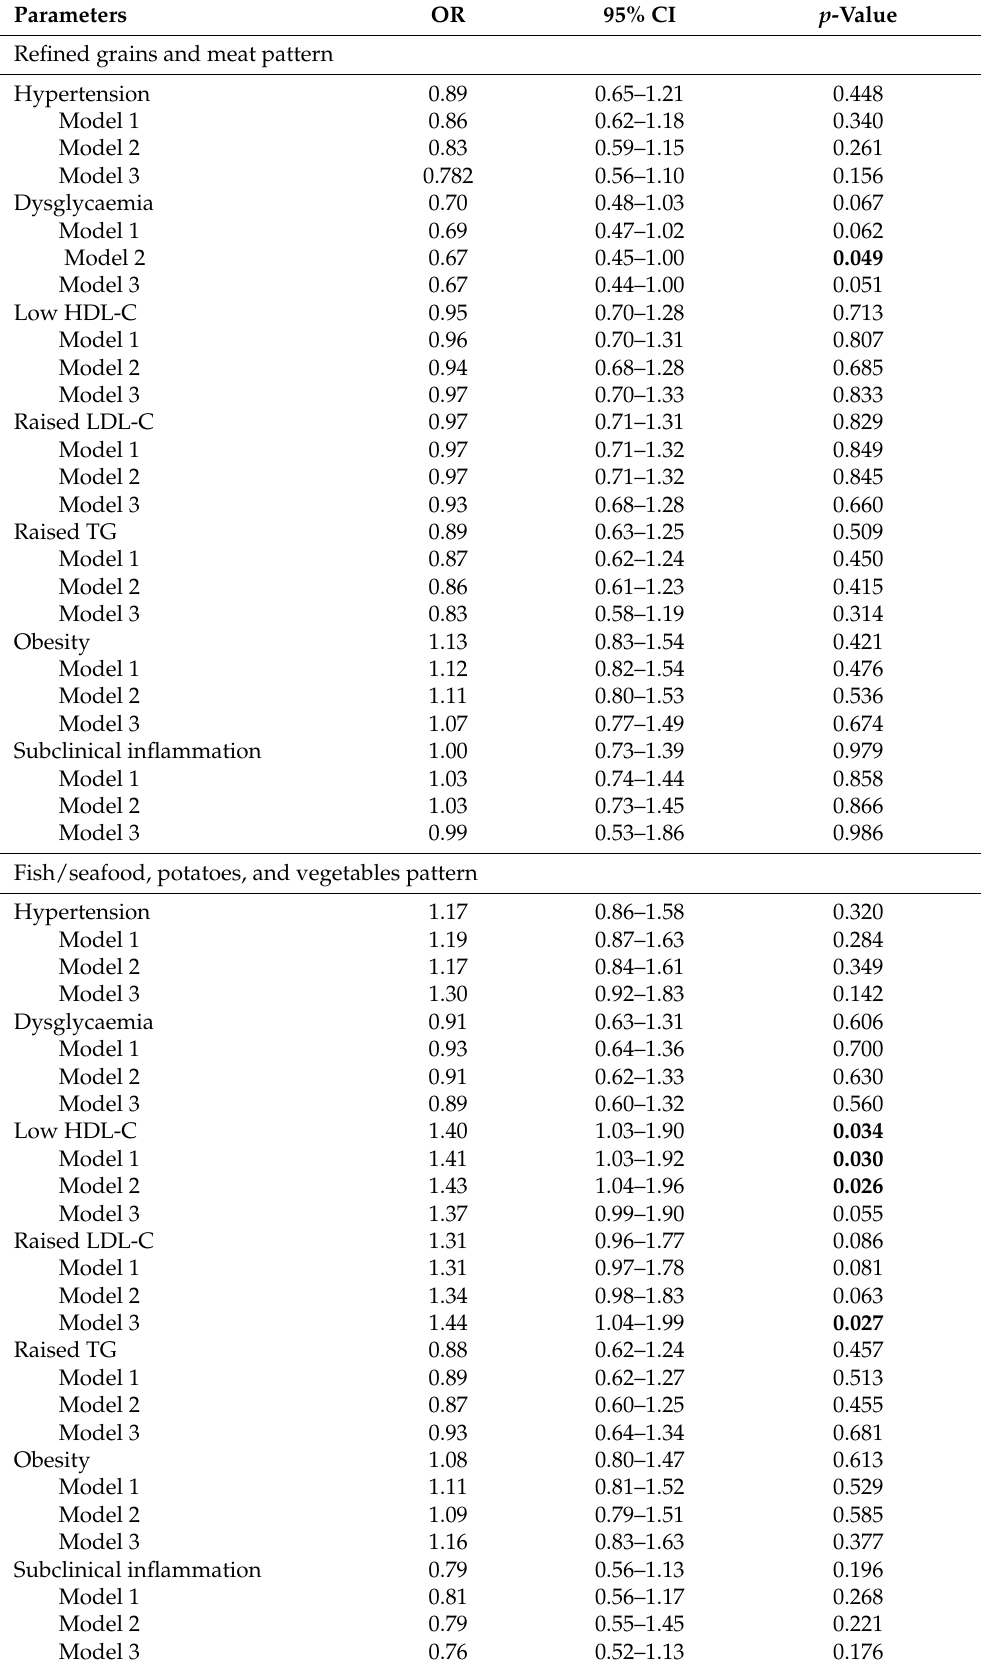
Table 7. Association between PCA-derived dietary patterns and cardiometabolic risk profiles.